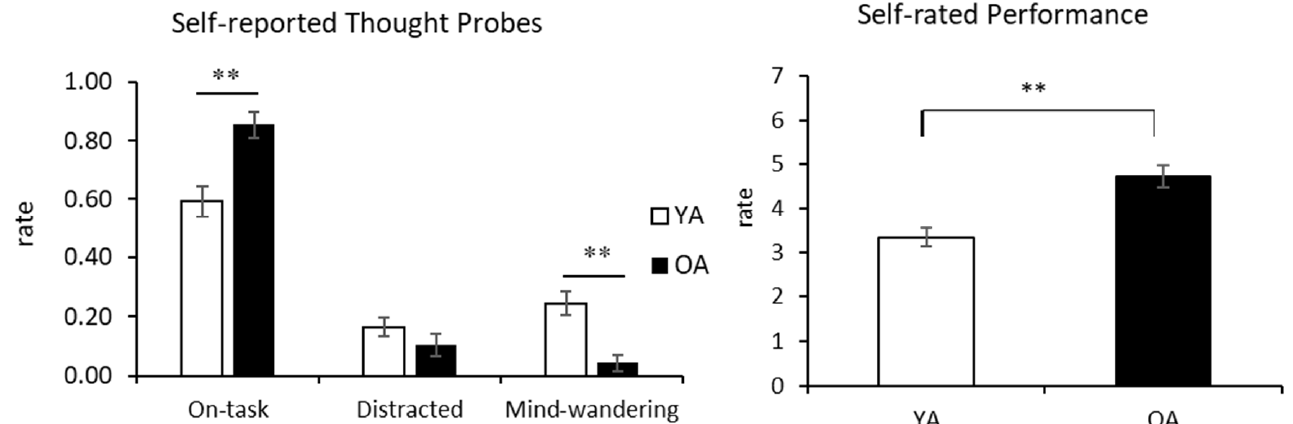
Figure 3. Age differences in self-aware attentiveness and performance. Results are shown separately for self-reported thought probes and performance. The frequency of reporting on-task and being MW significantly differed among age groups. In terms of self-rated performance, older adults tended to rate higher about their performance. Error bars represent one standard error from the mean. ** p < 0.01. Table 4. Bivariate correlation between SART performances and subjective ratings of attentiveness.